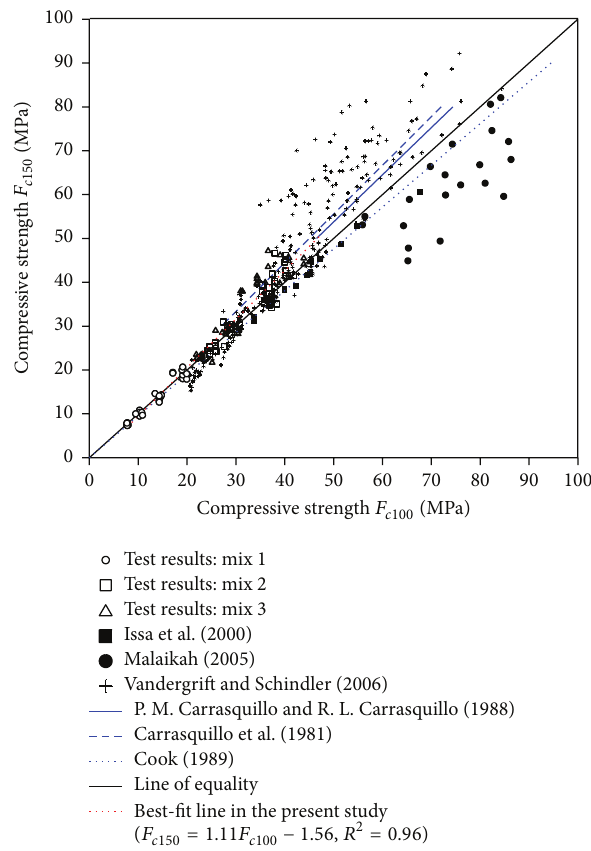
Figure 3: Comparison of compressive strength of concrete mea- sured from 100 by 200 mm and 150 by 300 mm cylinders ( 𝐹 𝑐100 and 𝐹 𝑐150 ,